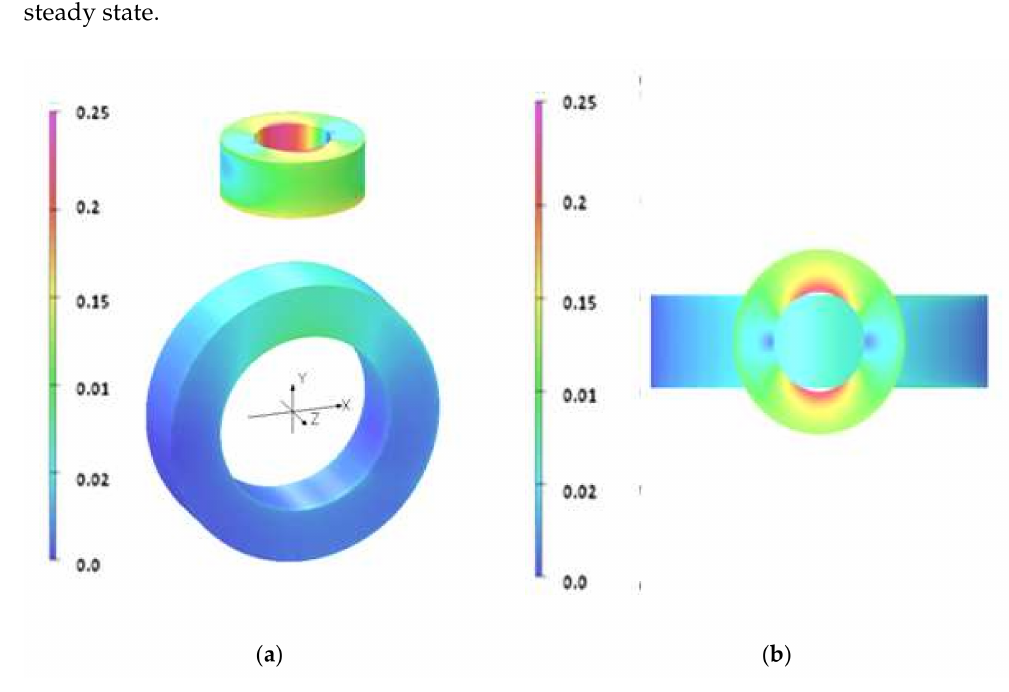
Figure 3. Magnetic flux density (T) distributions in the cores of short-circuit current transformers 50 kA/5 A at the rated primary current of 50 kA in a steady state: side view ( a ) and top view ( b